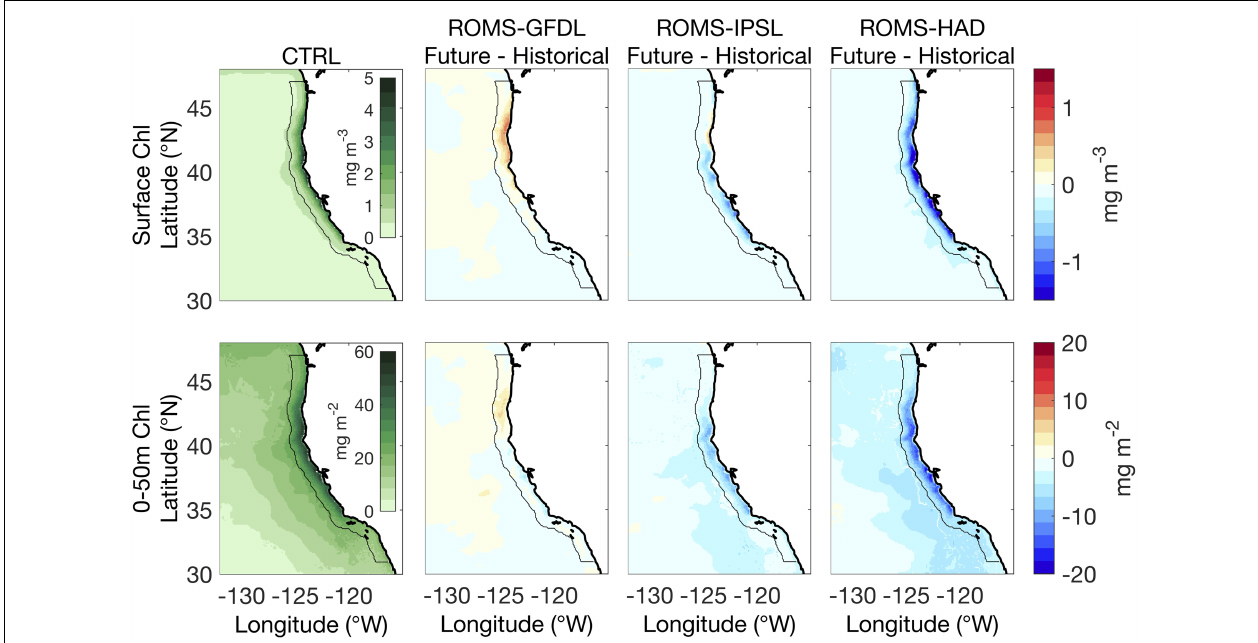
FIGURE 4 | Control run (1980–2010) mean and future changes (2070–2100 relative to historical) for the surface (top) and integrated (0–50 m, bottom ) chlorophyll (Chl). Columns show data for the historical period in the control simulation (CTRL, first) and the future changes from the high-resolution downscaled projections: ROMS-GFDL (second column), ROMS-IPSL (third column), and ROMS-HAD (fourth column). Black contour marks 100 km from shore.